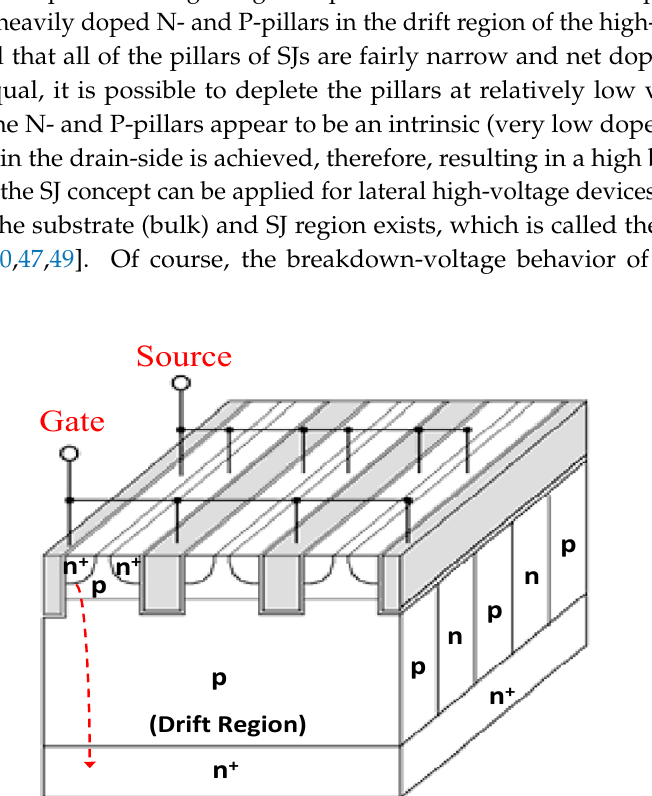
Figure 2. Lateral DMOS with an SJ structure in the drain side. 2. Device Layouts of UHV 300 V nLDMOS Related Devices 2.1. The Benchmarked Reference Sample (Pure nLDMOS) The layout diagram and 3-D cross-sectional view (along the line AB of Figure 3a) of a UHV 300 V circular nLDMOS benchmarked reference device are shown in Figures 3a and 3b, respectively. In Figure 3a, due to the high operation voltage and high breakdown voltage need, a lightly n-doped HVNW layer is used in the drain-side drift region. The PBody and deep P-Well (DPW) layers will form a reduced surface-field (RESURF) structure, which causes the drift region to be completely depleted and increases the breakdown voltage of the device [30]. Similarly, the poly2 surround above the drift region is used to increase the breakdown voltage. In the rectangular-type layout, the current will flow through and concentrate at the electrode corner; therefore this component is easily damaged there. Instead, in Figure 3b, the layout of a UHV MOSFET adopts a circular mode due to the conduction current uniformly flowing along the shortest radial-outward path and a circular structure is used in order to prevent the current’s uneven flowing. Meanwhile, a gate-grounded MOSFET (GGnMOS) structure is commonly used in the routing architecture of an ESD protection device, which discharges the instantaneous current of an external transient pulse mainly through the parasitic bipolar-junction transistor (BJT) conduction of this GGnMOS component. These experimental samples were fabricated by a TSMC 0.5 μ m UHV BCD process with a channel length L of 2.5 μ m and a channel width W of approximately 394.3 μ m.